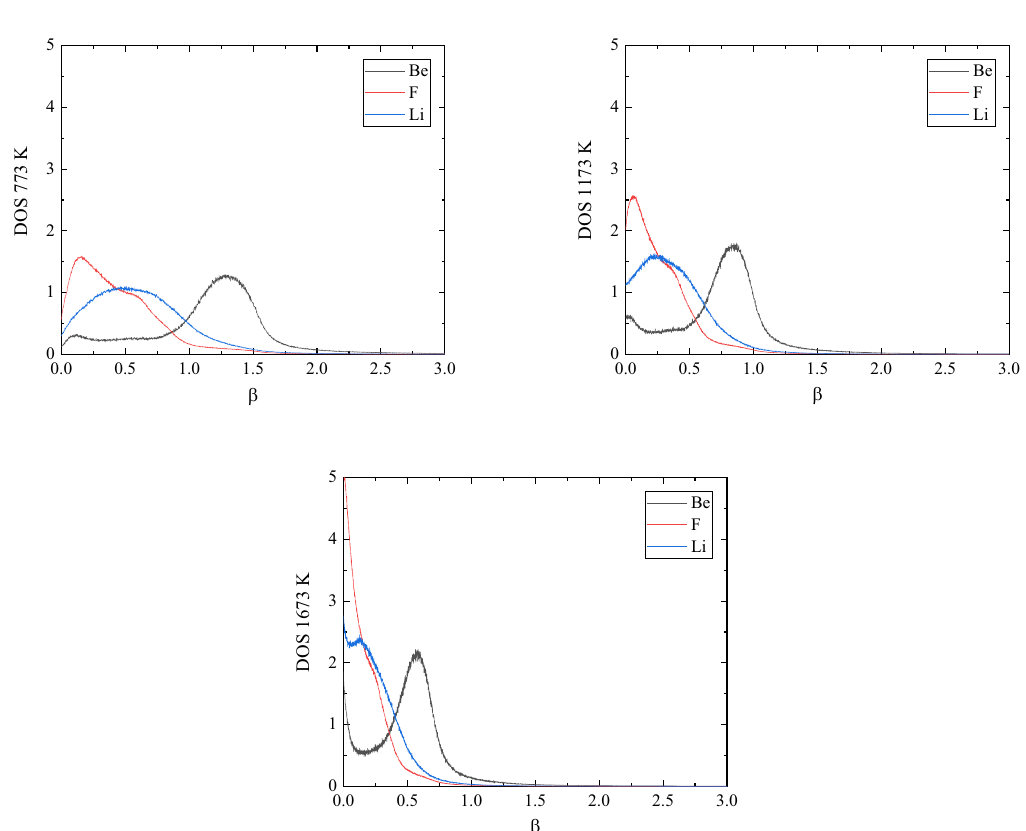
Figure 2. Total GDOS for Be, F, and Li in FLiBe at 773 K (left top), 1173 K (right top), and 1673 K